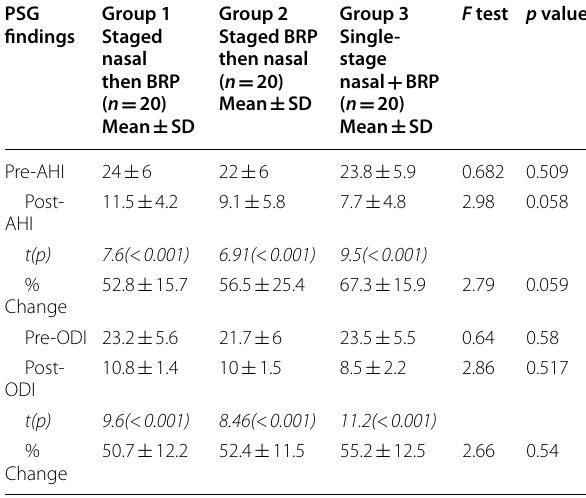
Table 4 Pre‑ and post‑operative PSG findings (AHI, ODI events/h) in OSA patients who underwent staged and single‑ stage multilevel surgery